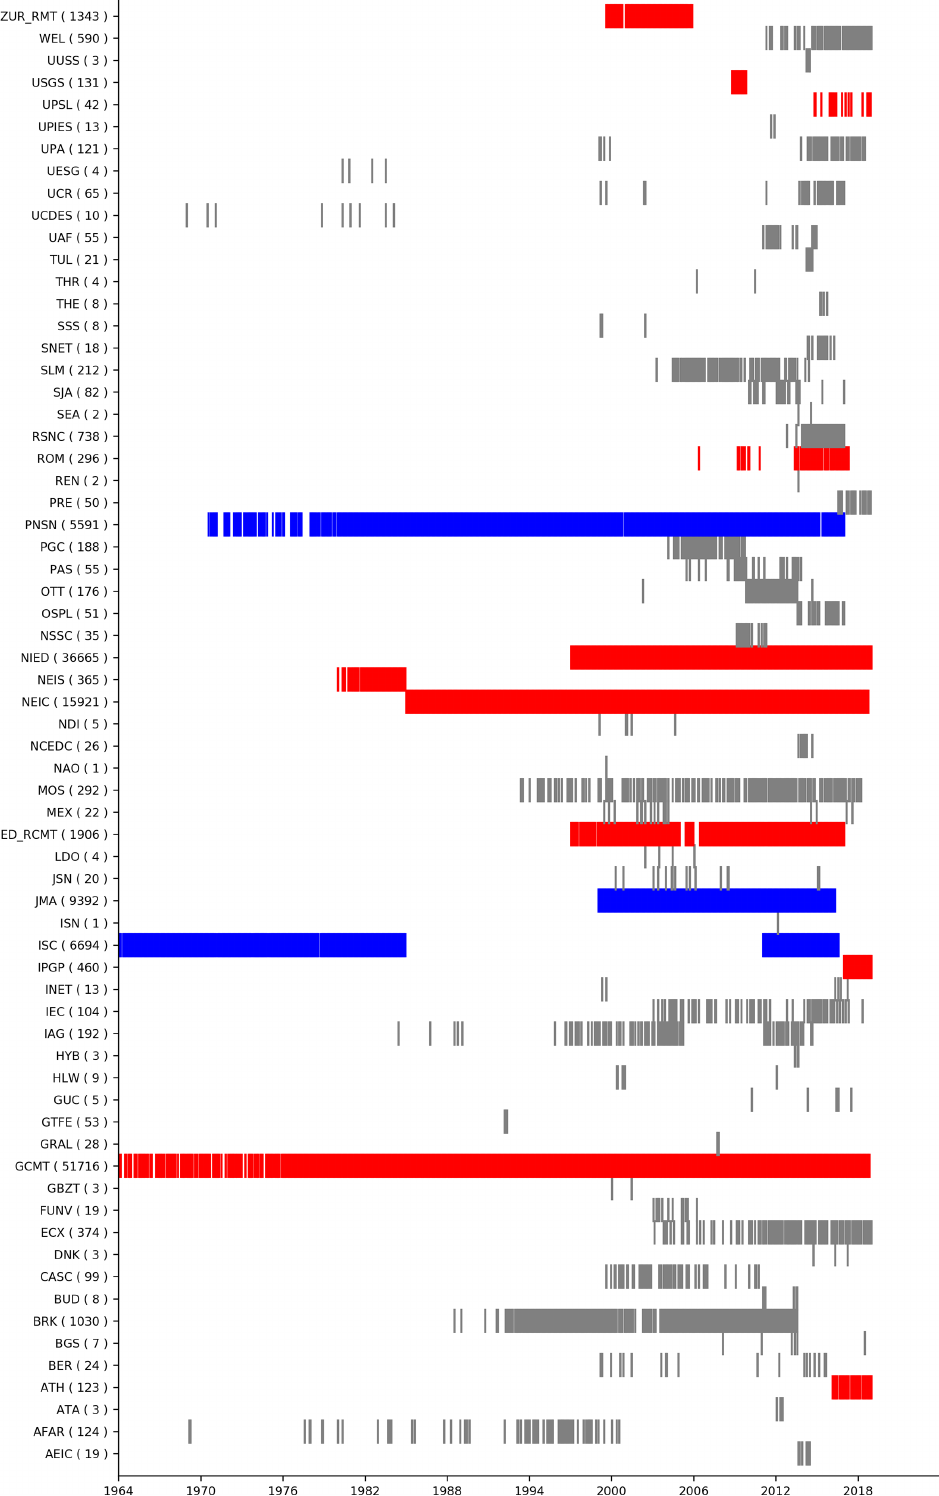
Figure 2. Time distribution of source mechanisms in the ISC Bulletin (January 1964–December 2018) reported by different agencies. The numbers in brackets next to each agency code show the total number of reported source mechanism solutions. Red lines indicate waveform inversion techniques, blue lines indicate first motion polarity techniques, and grey colour shows cases where there is no information available on the techniques being used or we could not verify them. A detailed list of the reporting agencies is shown in Table 1.